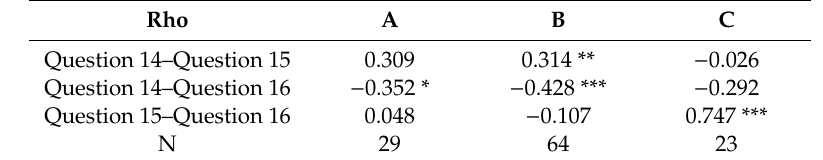
Table 4. The results of the pairwise Spearman correlation analyses for the variables of question 14 (How important to you is that you are able to control the level of electric lighting over your desk?), question 15 (What degree of control do you have over the electric lighting above your work plane?) and question 16 (How satisfied are you with this level of control?) for the three examined buildings. Rho A B C Question 14–Question 15 0.309 0.314 ** − 0.026 Question 14–Question 16 − 0.352 * − 0.428 *** − 0.292 Question 15–Question 16 0.048 − 0.107 0.747 *** N 29 64